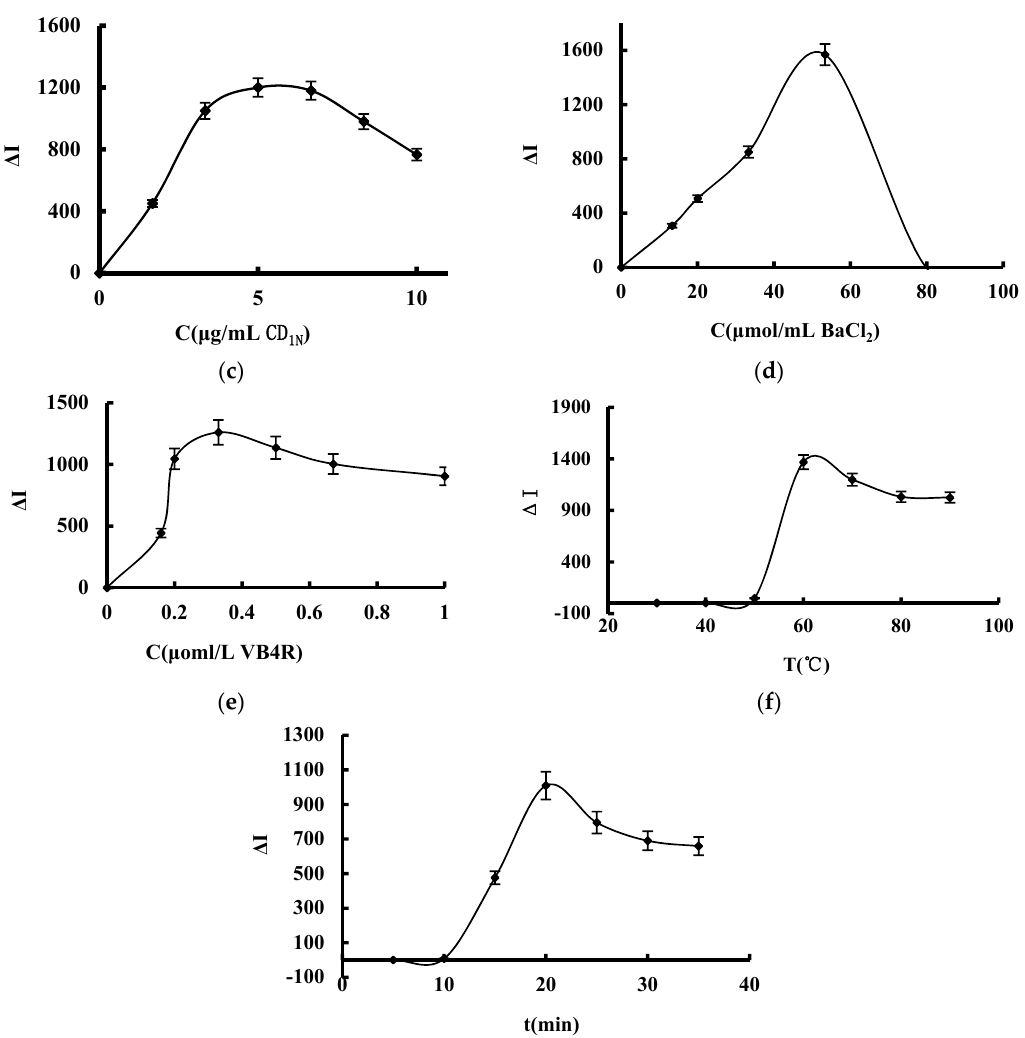
Figure 6. Effect of reagent concentration, reaction temperature and time. ( a ): HAuCl 4 + 2.5 mmol/L